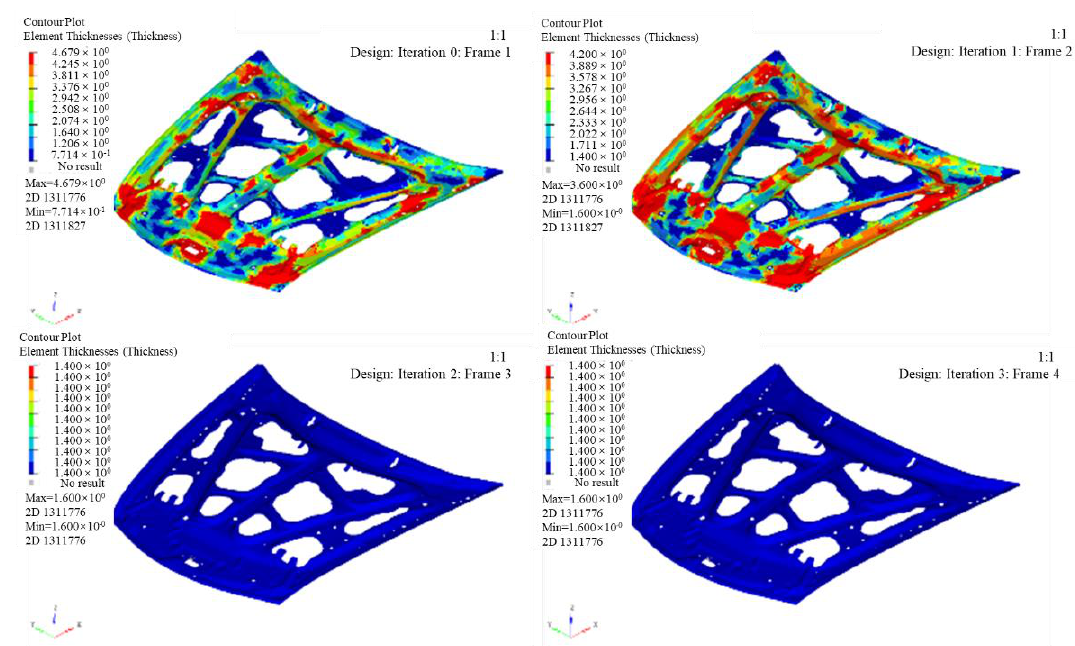
Figure 9. Contour map of outer plate thickness after thickness optimization.